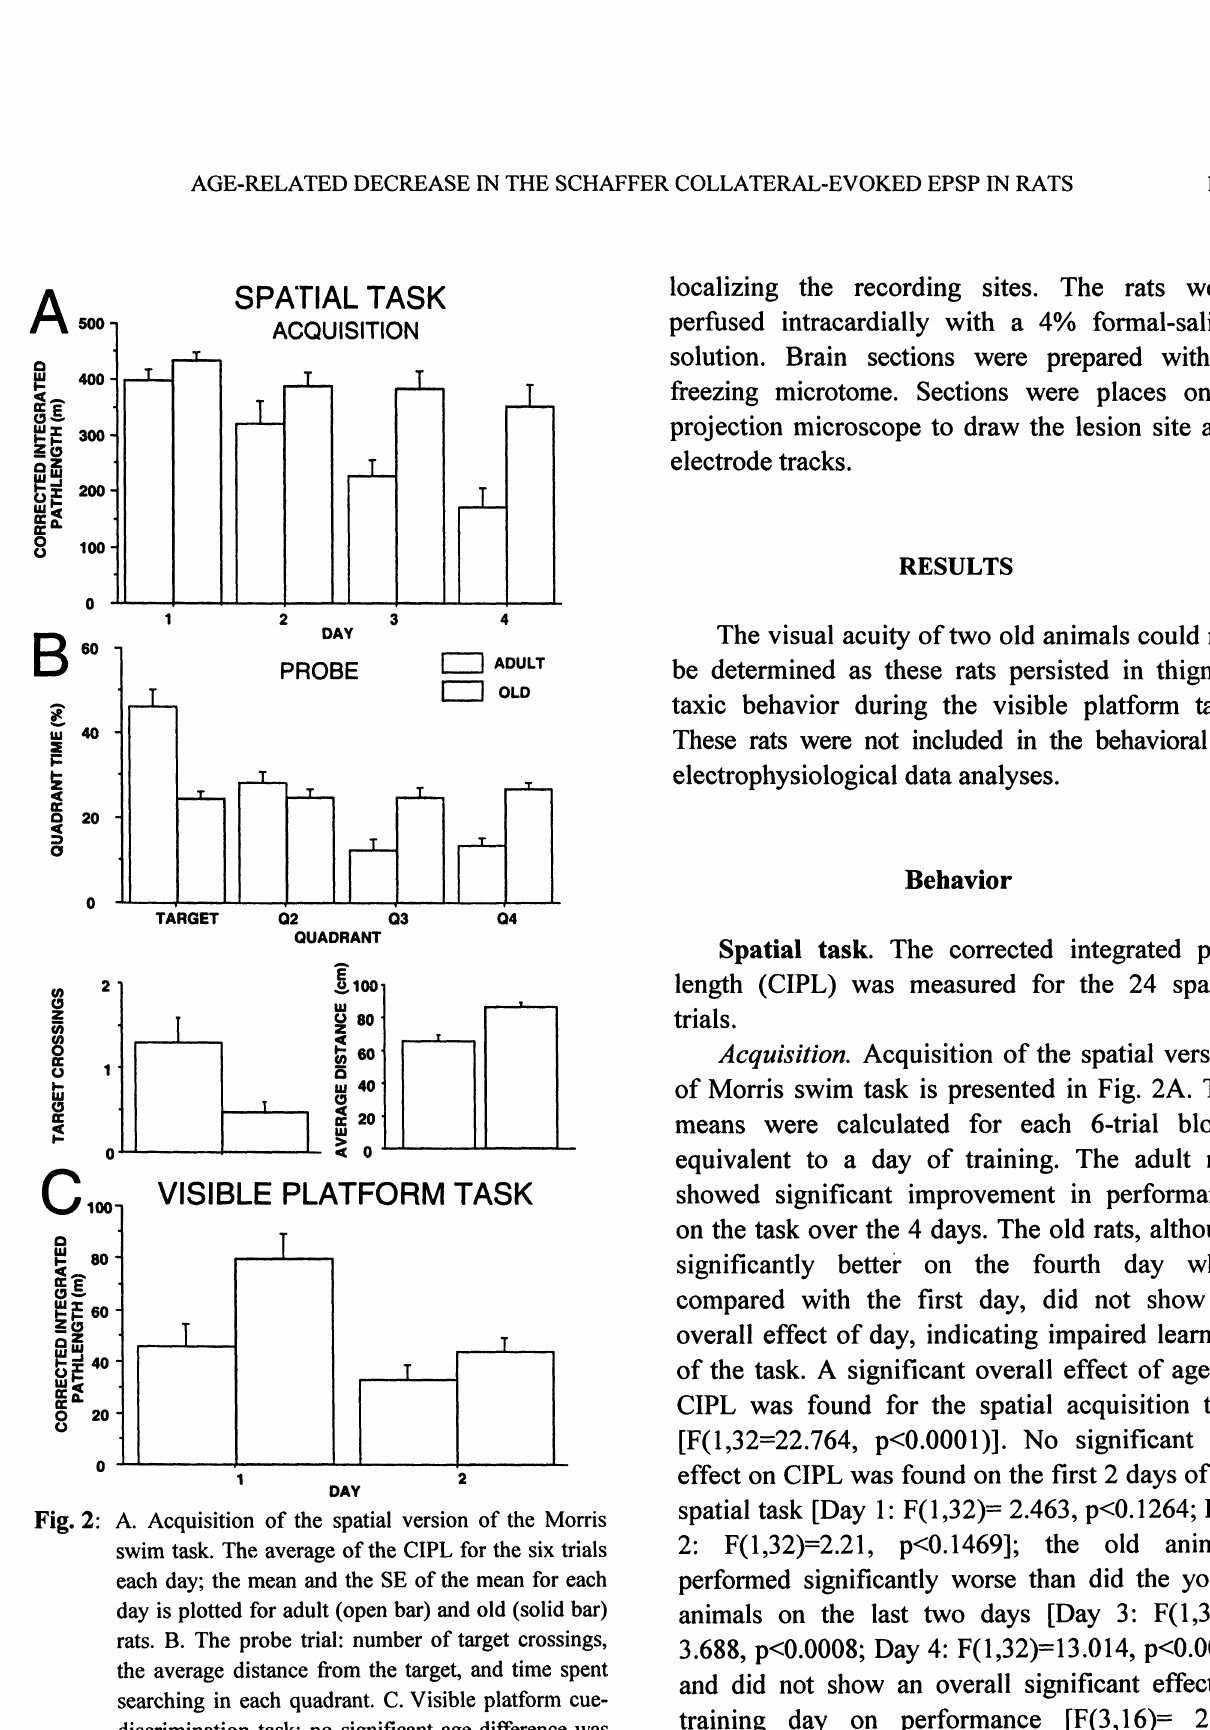
: A. Acquisition of the spatial version of the Morris Fig. swim task. The average of the CIPL for the six trials each day; the mean and the SE of the mean for each day is plotted for adult (open bar) and old (solid bar) rats. B. The probe trial" number of target crossings, the average distance from the target, and time spent searching in each quadrant. C. Visible platform cue- discrimination task: no significant age difference was found on the second